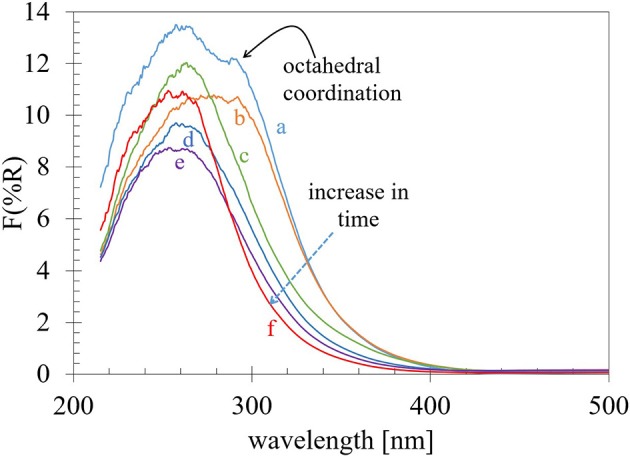
UV–vis diffuse reflectance absorption spectra for the (a) TiO2-ref, (b) Ti-nR-1, and (c) Ti-nR-5, (d) Ti-nR-10, (e) Ti-nR-15, (f) Ti-nR-30 samples.